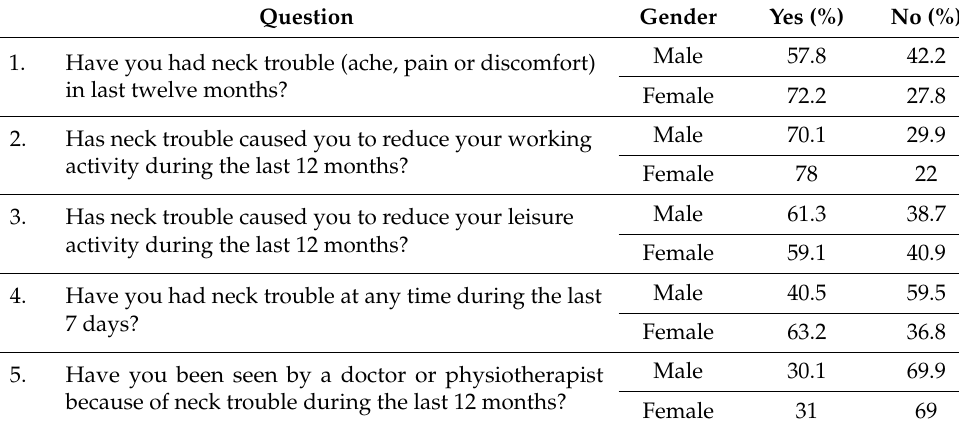
Table 2. Neck pain history and its effect on work and daily